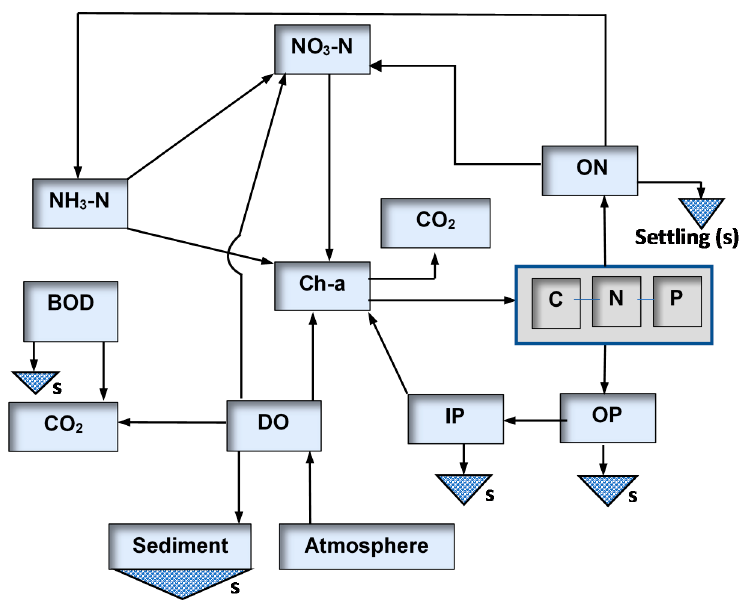
Figure 2. Water Quality Simulation Program (WASP) 8.1 graphical illustration of dynamic water ‐ quality parameters: ammonia as nitrogen (NH 3 ‐ N), nitrate as nitrogen (NO 3 ‐ N), Inorganic Phosphorus (IP), Chlorophyll ‐ a (Ch ‐ a), Oxygen Dissolved (DO), Biological Oxygen Demand (BOD), Organic Phosphorus (OP), and Organic Nitrogen (ON).